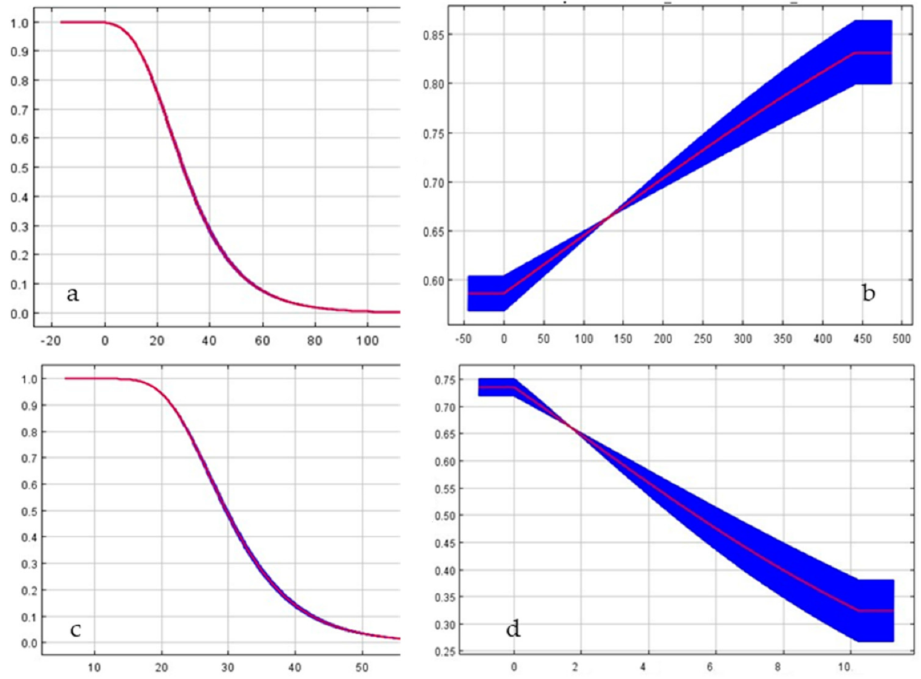
Figure 3. Response curves illustrating the relationship of predicted probability of Z. tenebrioides occurrence to top four contributing environmental variation; ( a ) Coefficient of seasonal pattern of precipitations (bio 15); ( b ) Precipitations of driest quarter (bio 17); ( c ) Precipitations during the coldest quarter of the year (bio 19); ( d ) Annual temperature range (bio 7).